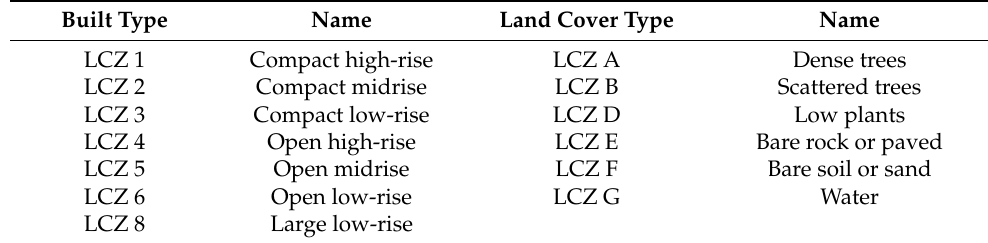
Table 4. The LCZ classification scheme of Wuhan